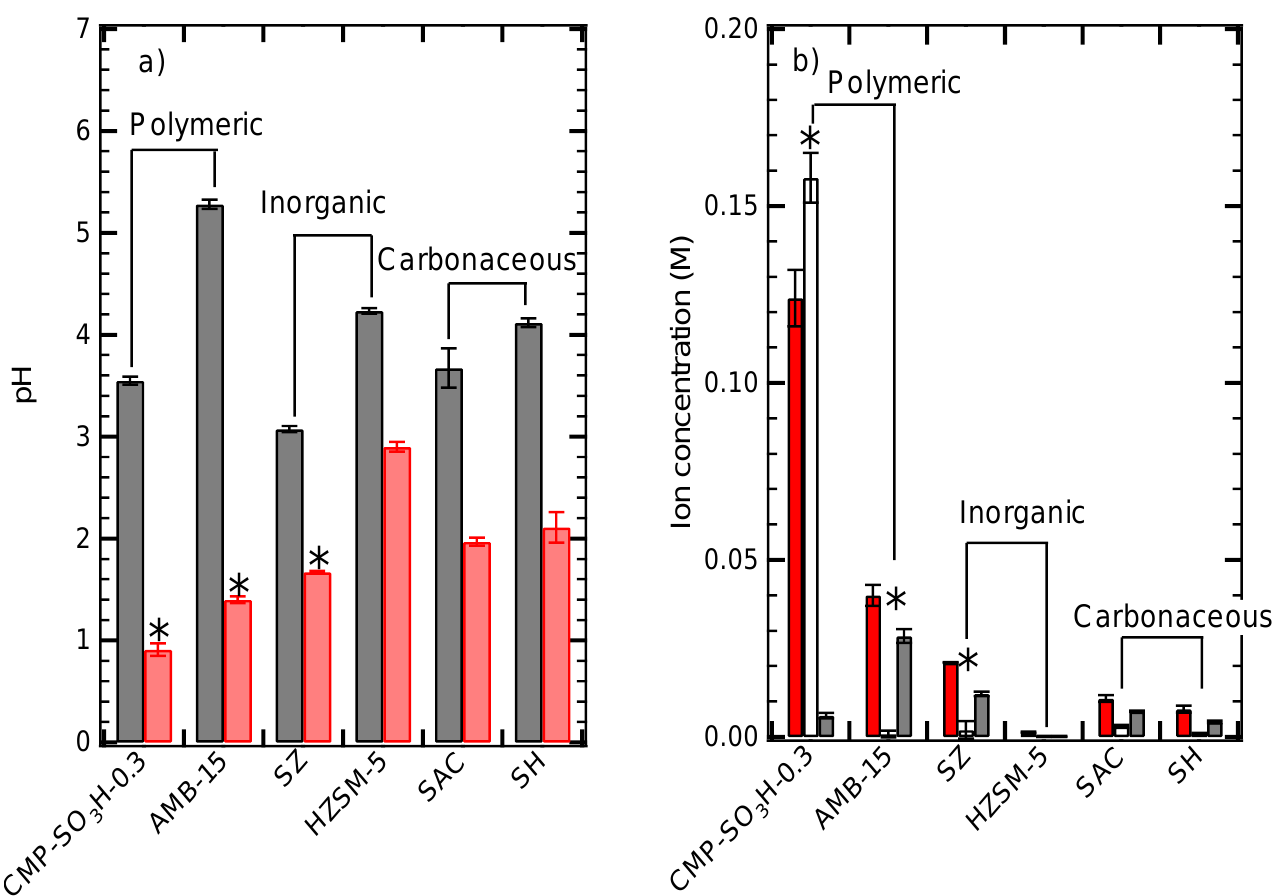
Figure 3. Hydrothermal stability of catalysts and leached acid characterization. In ( a ), gray bars indicate pH of catalyst suspension in water after wash and red bars indicate pH after treatment at hydrothermal conditions (0.2 g of catalyst, 2 mL of water, 150 ◦ C, 15 h). In ( b ), red bars represent H + , white bars represent Cl − , and gray bars represent HSO 4 − ions. * Duration of the hydrothermal treatment was 10 h.